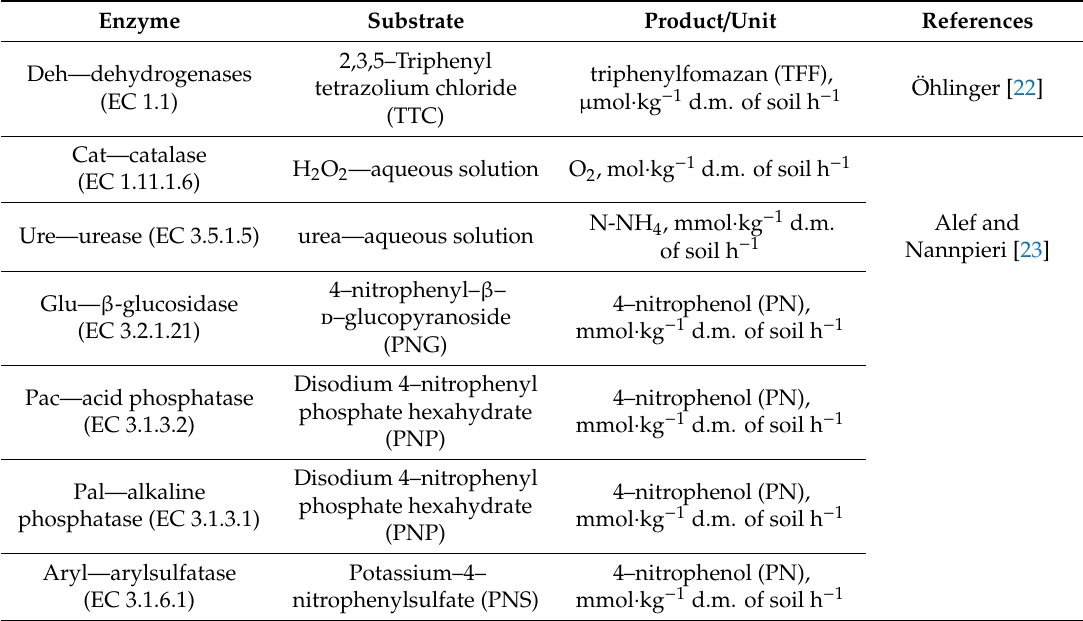
Table 4. Methods of determination of soil enzyme